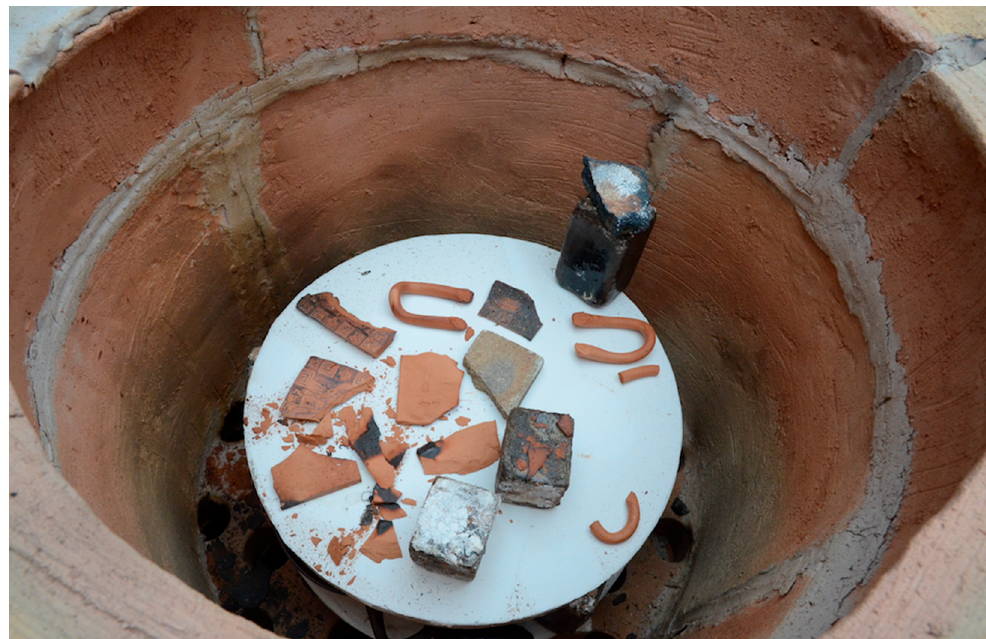
Figure 9. The explosion of test tiles in the April 2015 firing.